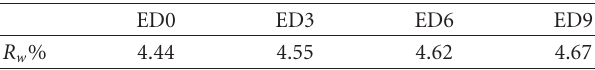
Table 4: The R w % comparison of di ff erent etching depths after ARC